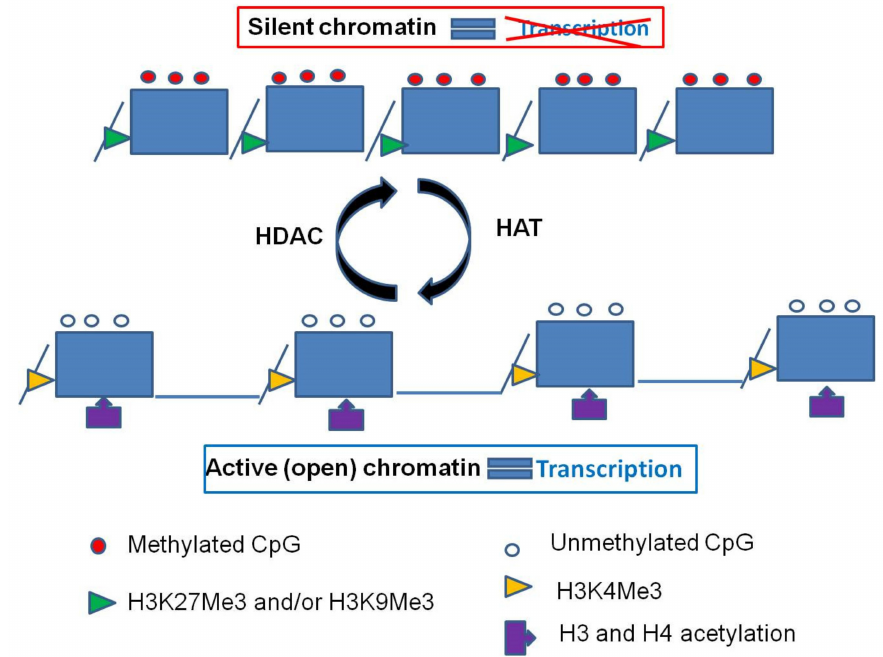
Figure 3. A: CpG islands of actively transcribed genes are unmethylated and have trimethylation at histone H3lysine residue K4 (H3K4Me3) and acetylation on lysine residues at histones H3 and H4. B:Methylation of the CpG island is frequently associated with trimethylation of lysine residue K27 or trimethylation of lysine residue K9 at histone H3, coupled with loss of the active marks H3K4Me3 and acetylated H3 and